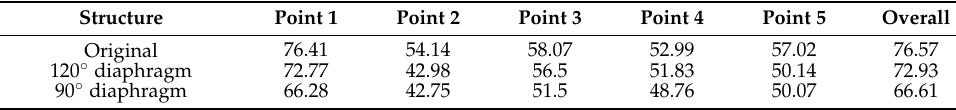
Figure 19. Surface sound pressure cloud image of 90 ◦ structure. Table 1. Noise measurement data comparison